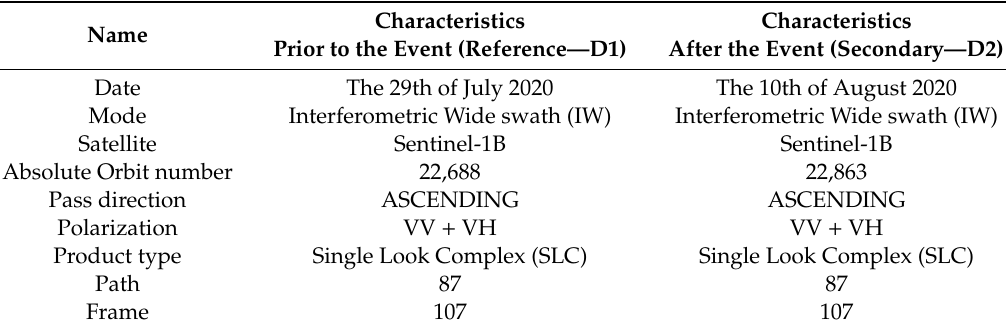
Table 3. Sentinel-1 data used for the InSAR analysis (ascending